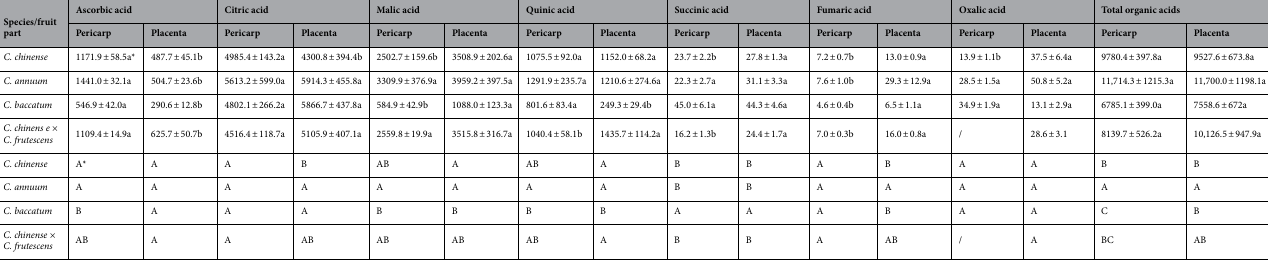
Table 2. Organic acids contents (mg/100 g DW, mean ± SE) in different species and two different fruit parts. * a,b Lower case letters denote statistical significant differences (α < 0.05) among placenta and pericarp of individual organic acid and total organic acids in the same species. * A–C Upper case letters in same column denote statistical significant differences (α < 0.05) in organic acid concentrations among four different species separated for pericarp and